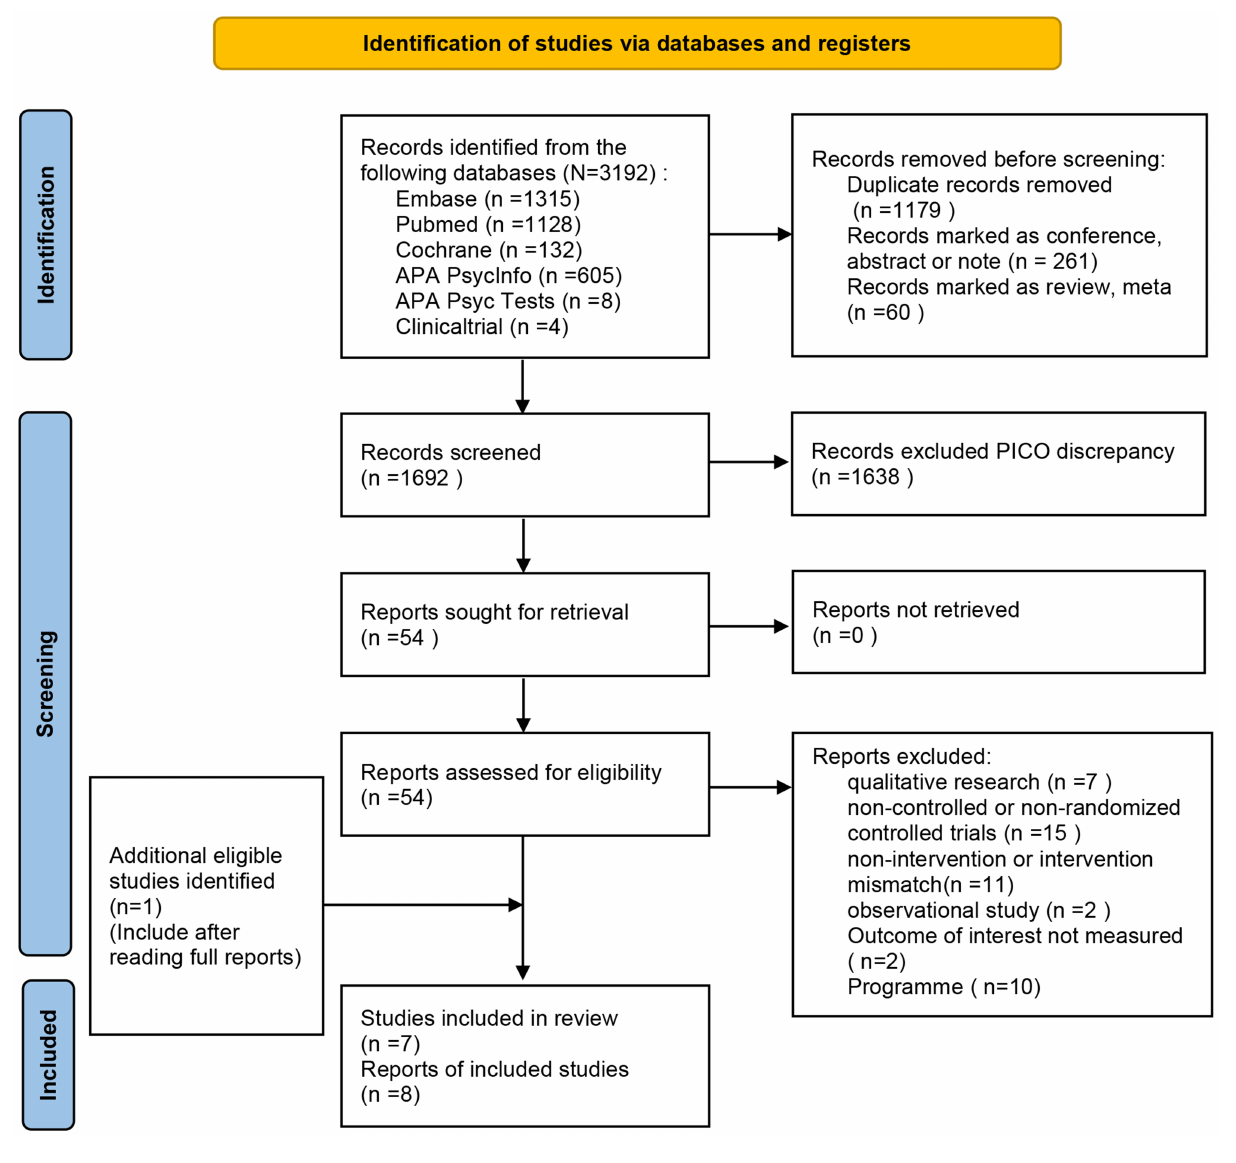
FIGURE 1 | PRISMA flow